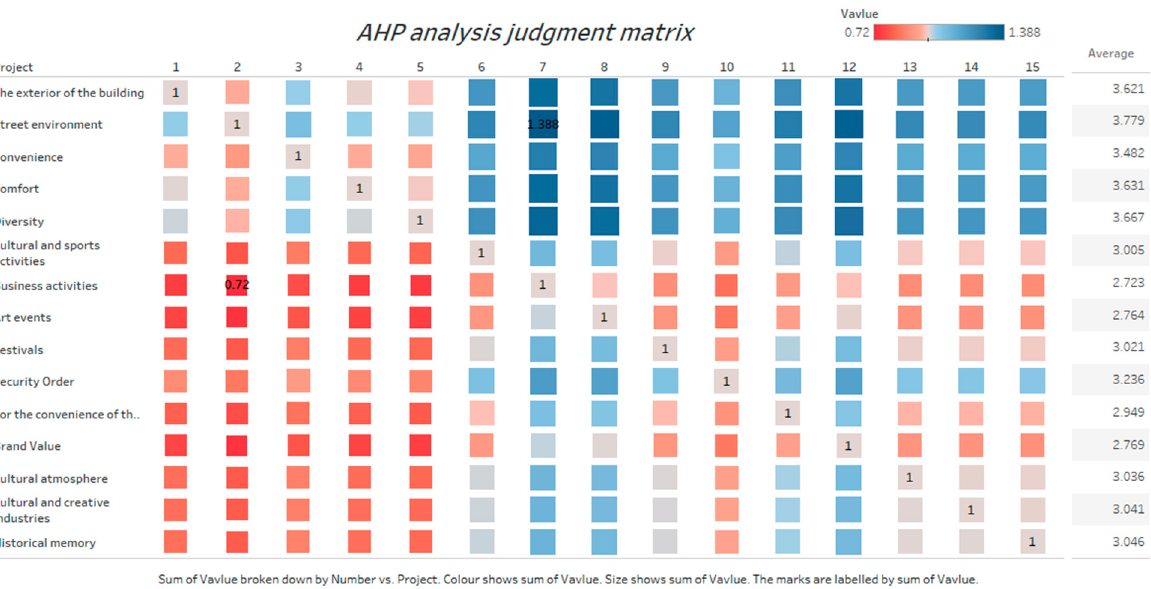
Figure 7. Satisfaction analysis of commercial space in Nonglin Street.